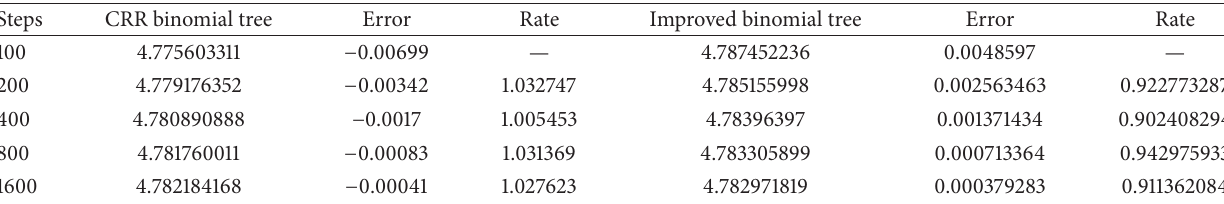
Table 1: Numerical results for Example 1.